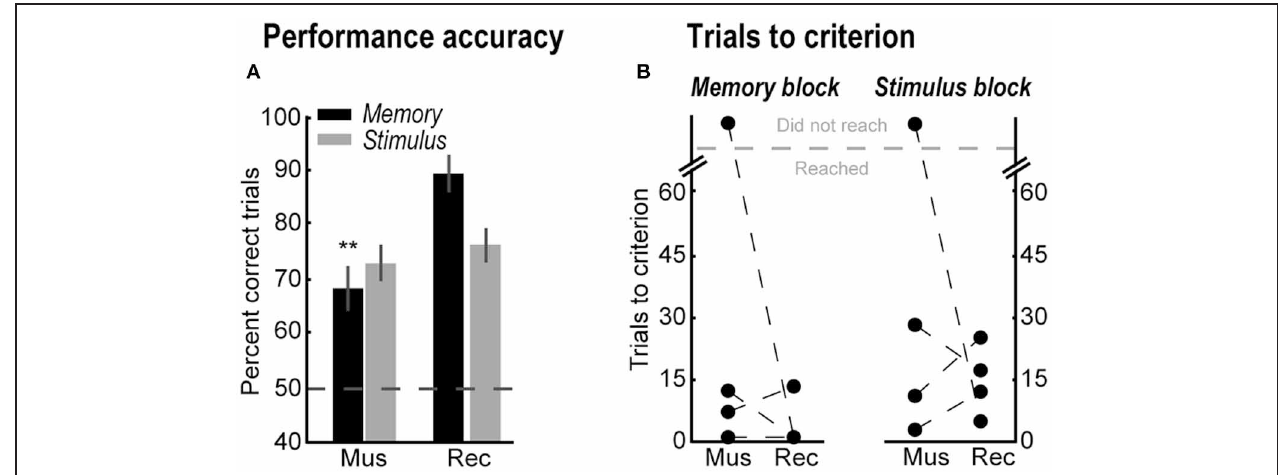
(B) Trials to reach the performance criterion in the memory- and stimulus-guided trails after muscimol infusions (Mus) and in the recovery session (Rec).